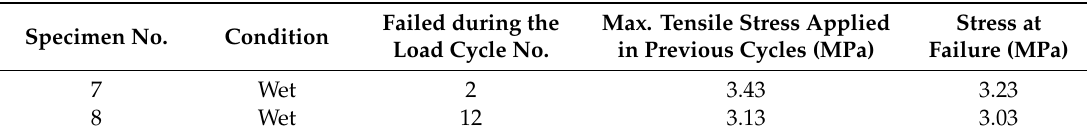
Table 3. Cyclic load results for specimens 7 and 8.